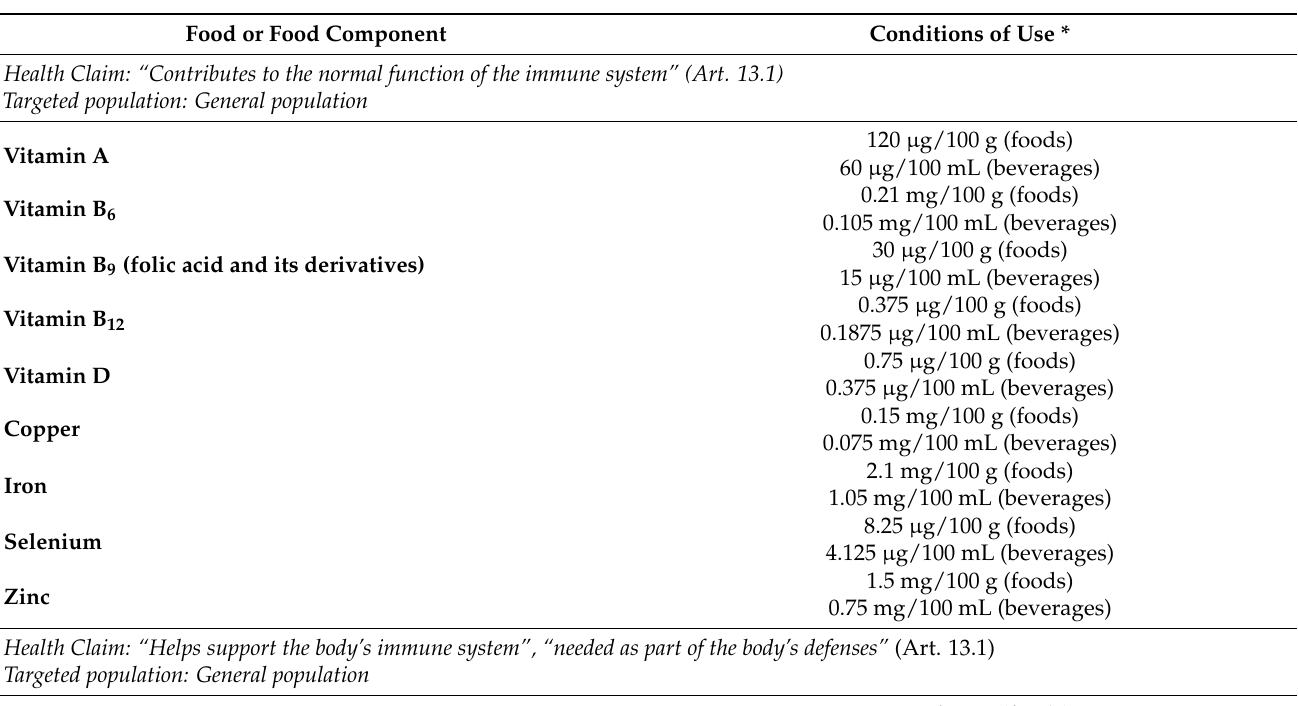
Table 1. Nutrients with EFSA authorized Health Claim related to Immune system function. Based on: EU Register on nutrition and health claims made on food